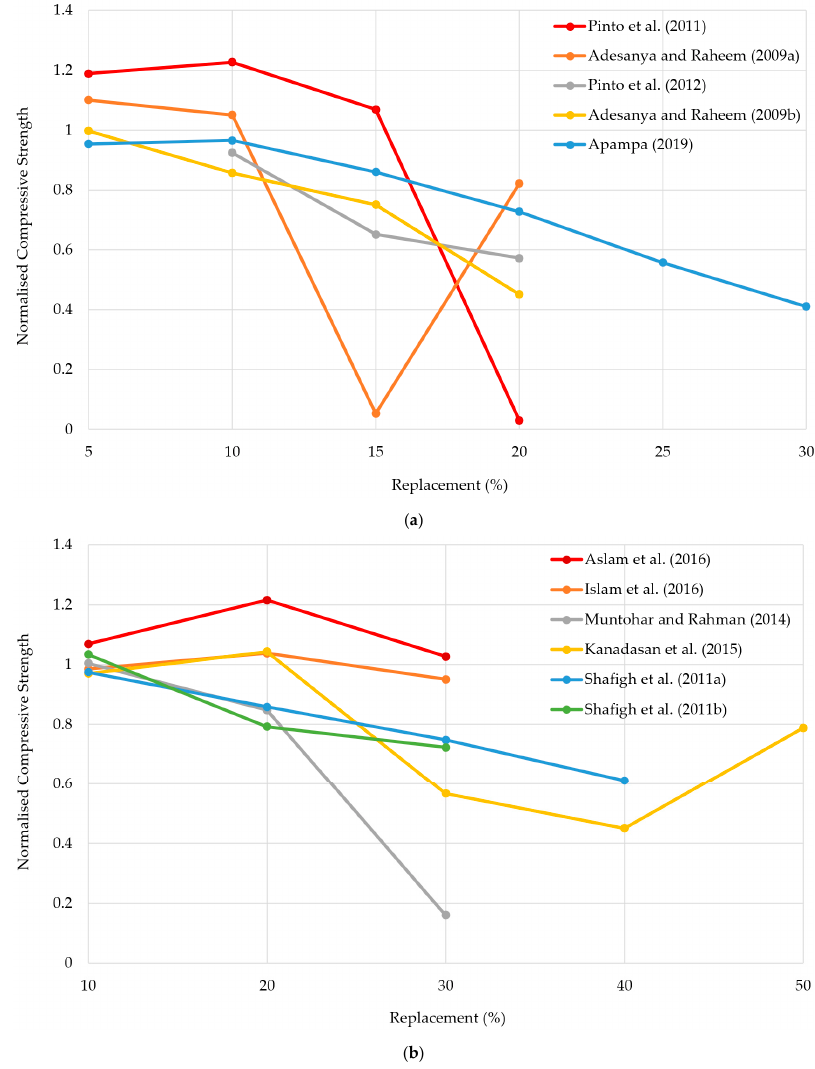
Figure 10. Cont . Figure 10. Cont